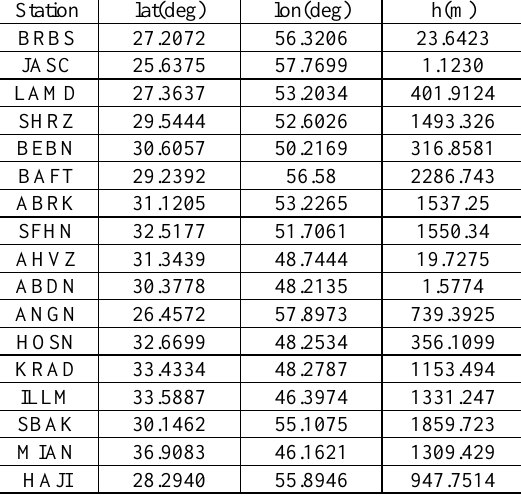
Table 1. The geodetic coordinates of the Zagros geodynamic stations